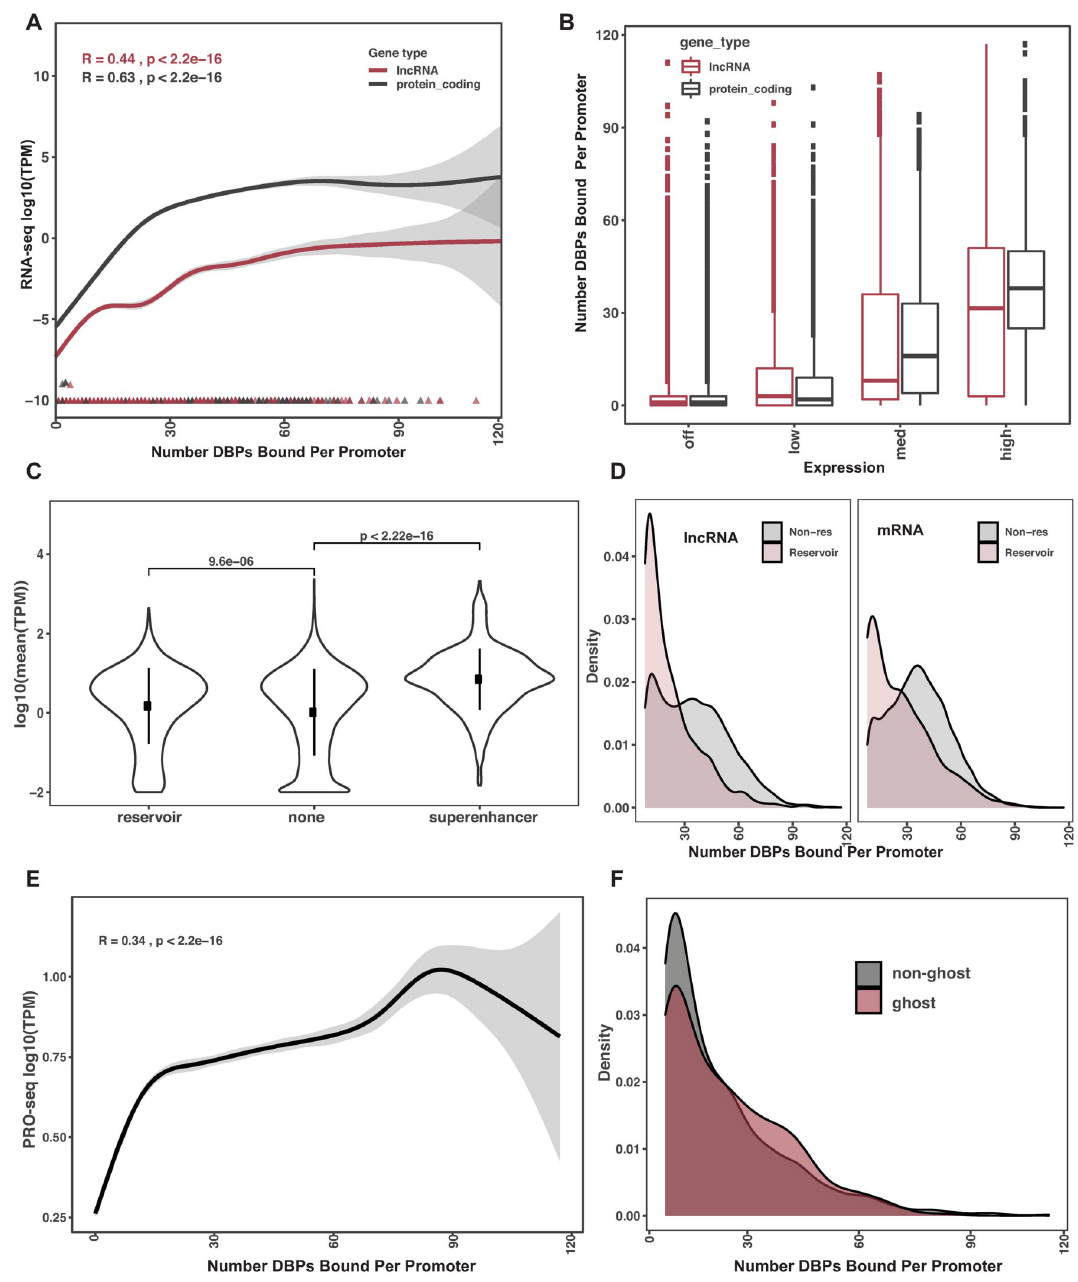
Fig 6. Reservoir promoters are comprised of ghosts and zombies. (A) Number of DBPs bound to a promoter (x-axis) versus log 10 (TPM) of transcription as measured by total RNA-seq. (B) Box plot comparing mRNA (black) and lncRNA (red) expression as a function of off, low, medium, and high expressed transcripts. Y-axis is the number of DBPs bound and X-axis is each category. (C) Y- axis is the mean expression level in windows of five genes excluding the center gene. X-axis is by category of windows containing a reservoir, non-reservoir or super-enhancer. (D) Density plot of number of DBPs bound at a promoter at expressed (grey) versus non- expressed promoters (red), separated by lncRNA and mRNA promoter types. (E) Nascent TPM expression within the 6kb promoter region (Y-axis) compared to number of DBPs bound at a promoter. (F) Density plots of DBPs ghost reservoirs (those without nascent expression, PRO-seq TPM < 0.001) vs those with detectable nascent expression (zombie